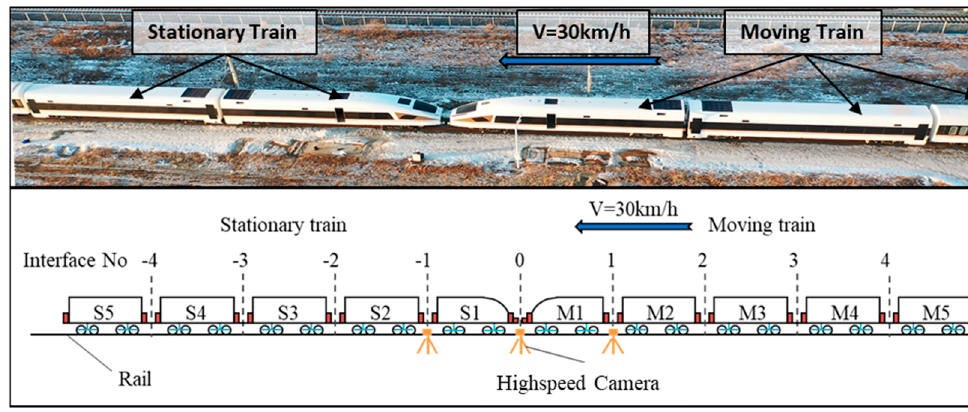
Figure 8. Experimental crash condition. Table 2. Train mass distribution in the test.